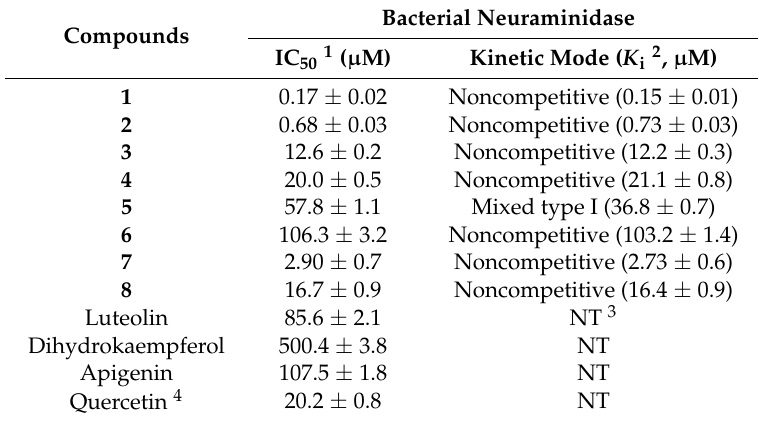
Table 2. Inhibitory effects of the compounds ( 1 – 8 ) on bacterial neuraminidase activity.